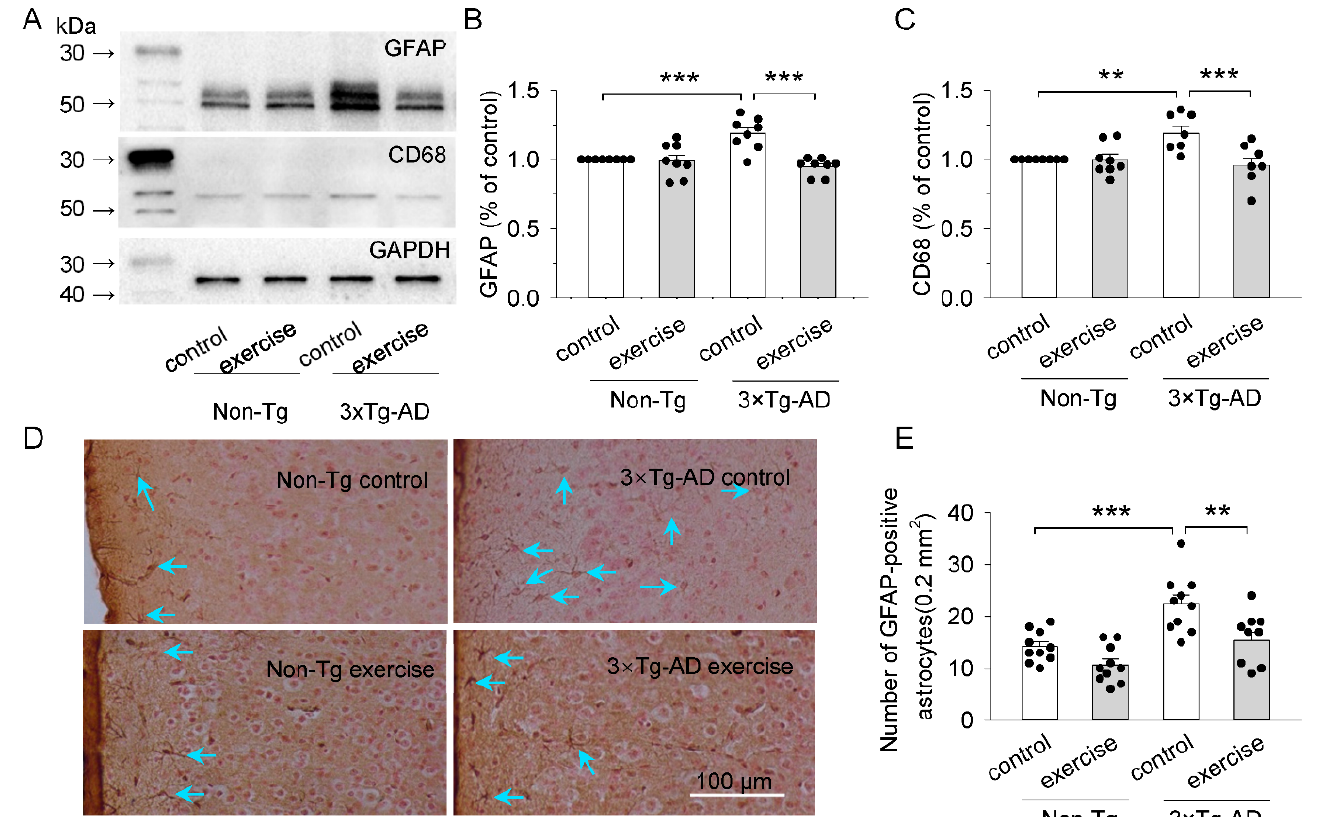
Figure 3. Treadmill exercise reduced astrocyte and microglia activation in 3 × Tg-AD mice. ( A ) Repre- sentative western blots for GFAP and CD68 of the prefrontal cortex homogenates were prepared from these four groups of mice. ( B , C ) Summarized data showed that GFAP (( B ), *** p < 0.001, n = 8-8 and CD68 (( C ), ** p = 0.003, n = 8-8) of the prefrontal cortex were significantly increased in the 3 × Tg-AD mice compared to the non-Tg control group and these increases were blocked by treadmill exercise pretreatment (*** p < 0.001, n = 8-8). ( D ) Representative microphotographs of the prefrontal cortex sections from six-month-old mice. Sections were stained antibody against GFAP ( n = 10/group). Blue arrows represent GFAP positive cells. ( E ) Quantitative analysis revealed that the number of GFAP-positive cells was significantly higher in 3 × Tg-AD mice compared to the non-Tg control group (*** p < 0.001, n = 10-10), and this increase was blocked by treadmill exercise pretreatment (** p = 0.001, n = 10-10). See Supplementary Figure S3 for uncropped